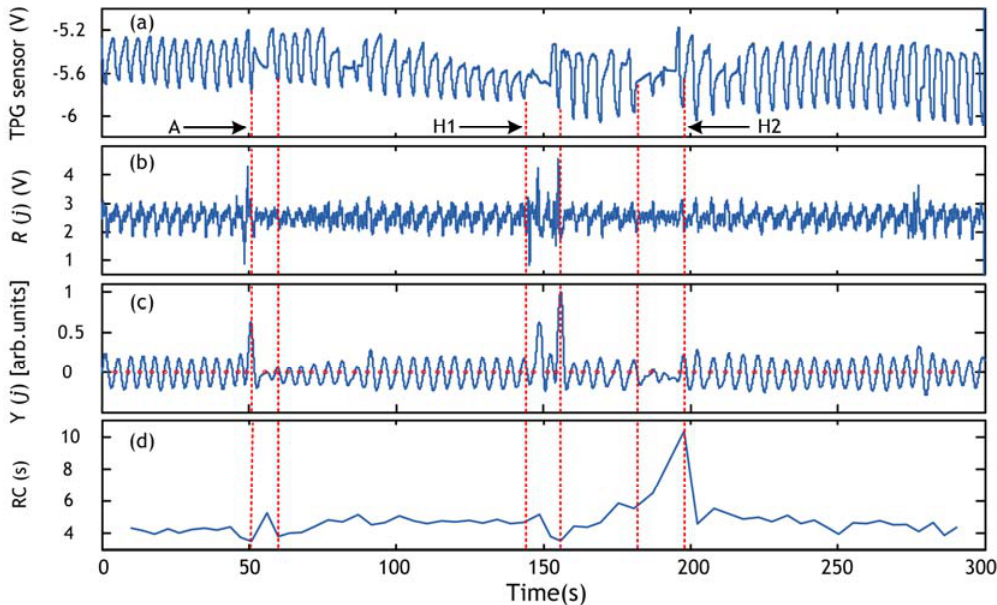
Figure 13. Hypopnea detection using respiratory cycle variability (RCV) for record 3. (a) Respiration signal obtained with commercial TPG sensor. (b) PVDF sensor output. (c) Respiration signal derived from (b) using local energy calculation and the RC detection algorithm. (d) RC calculated from (c). Circles represent respiratory cycle’s information estimated during inhalation time (positive slope). “H1” and “H2” represent hypopnea episodes whereas “A” represents abnormal respiration